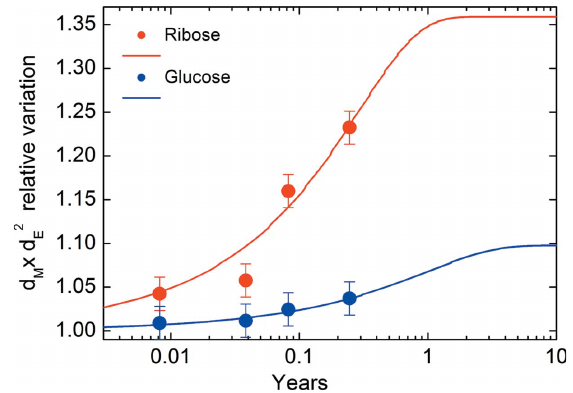
Figure 12 Variation of the volume occupied by glycated collagen with respect to the native molecule for a sugar concentration of 40 mg ml (cid:2) 1